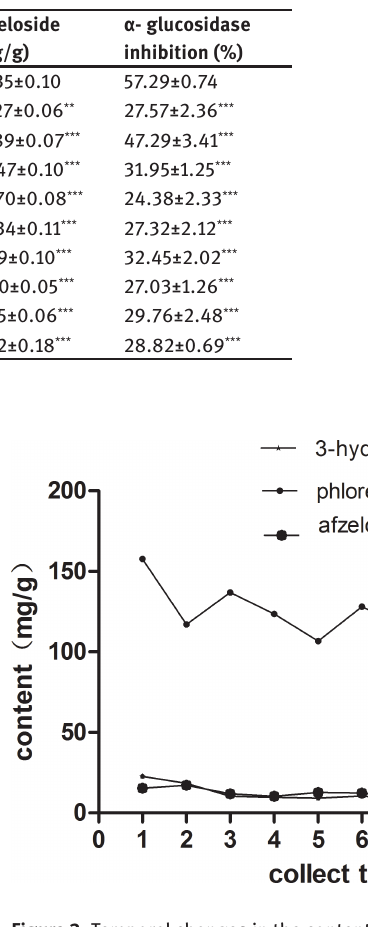
Figure 3: Temporal changes in the contents of 3-hydroxyphloridzin, phloretin-4’- O -glycosidase and afzeloside of M. halliana flowers during blooming.